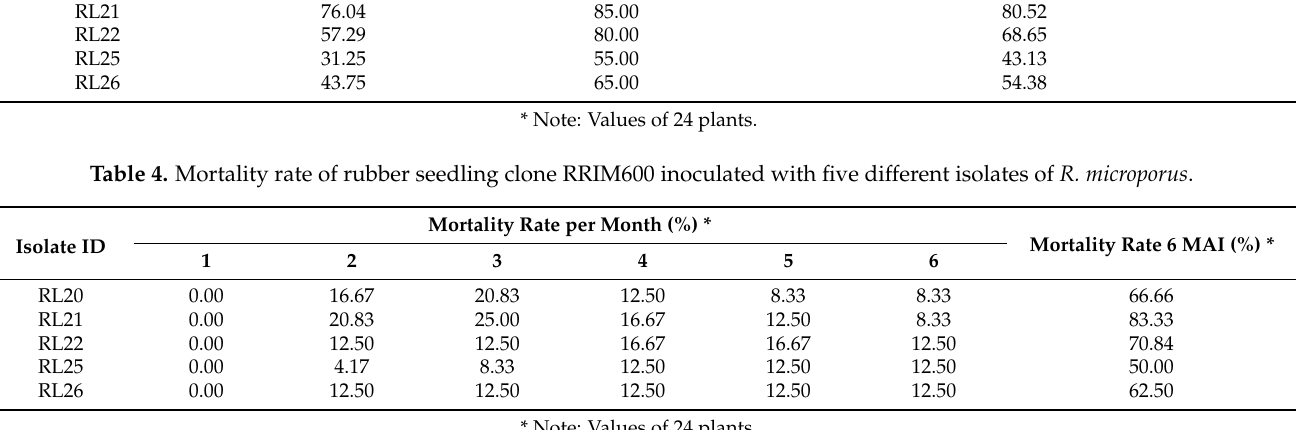
Table 3. Disease severity index of rubber seedling clone RRIM600 based on above- and below-ground symptoms six months after being challenged with five different isolates of R. microporus . Disease Severity Index * Average DSI of Above- and Below-Ground Symptoms Isolate ID Foliar Discoloration Root Rotting